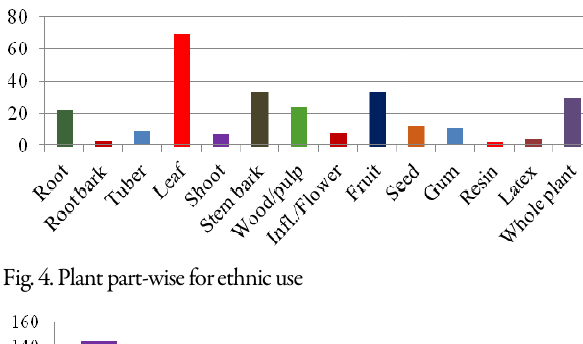
Fig. 3. Indigenous vs. exotic ethnobotanical plants in the sanctuary